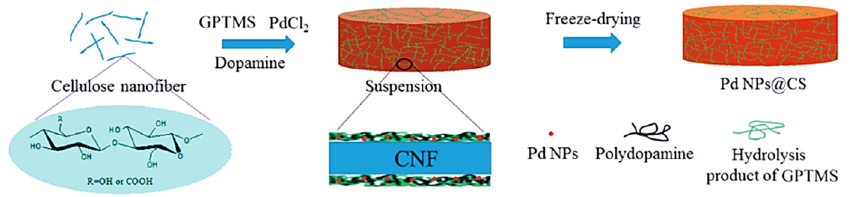
Figure 1. The schematic of the formation of Pd NPs supported by cellulose sponges. Reprinted with permission from [ 79 ] . Copyright 2017 American Chemical Society.